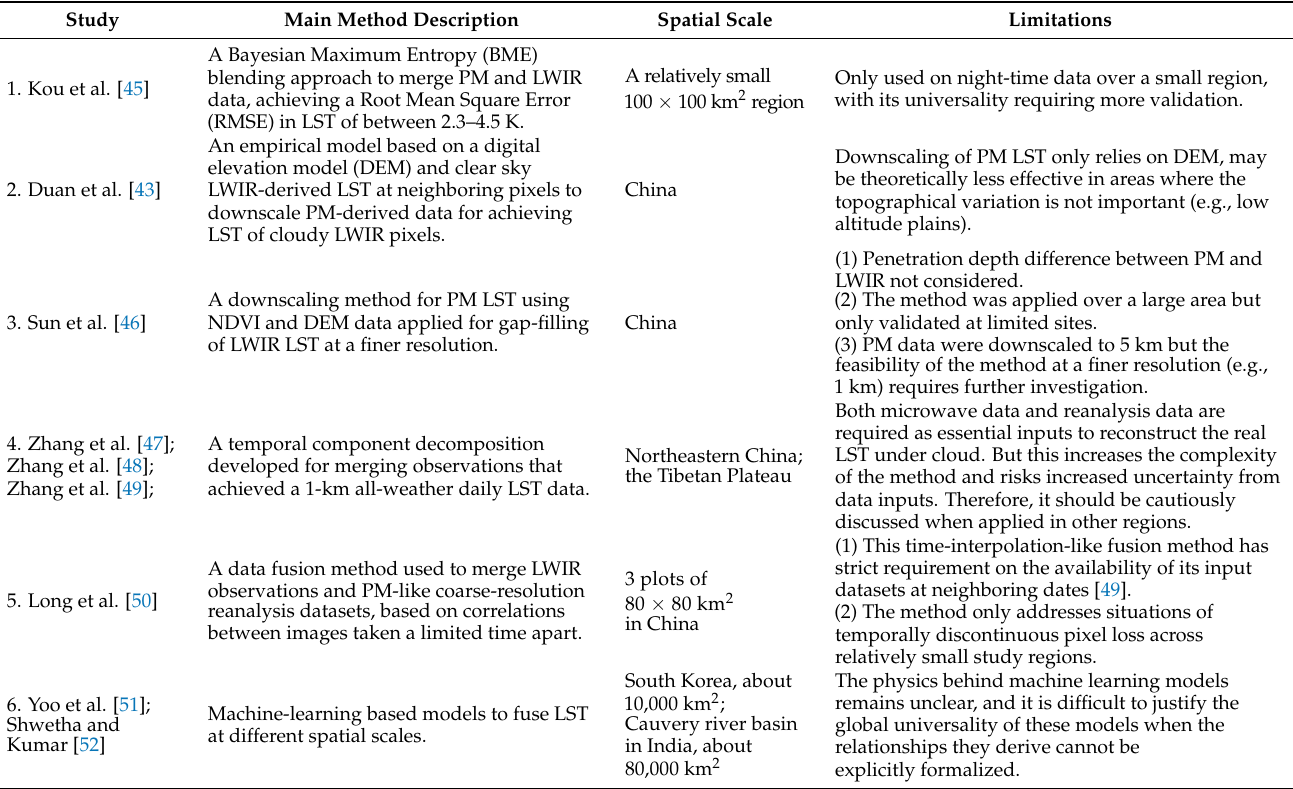
Table 1. Summary of LWIR and Passive Microwave data fusion studies related to the production of ‘all-weather’ daily LST information at a higher spatial resolution than PM data alone can